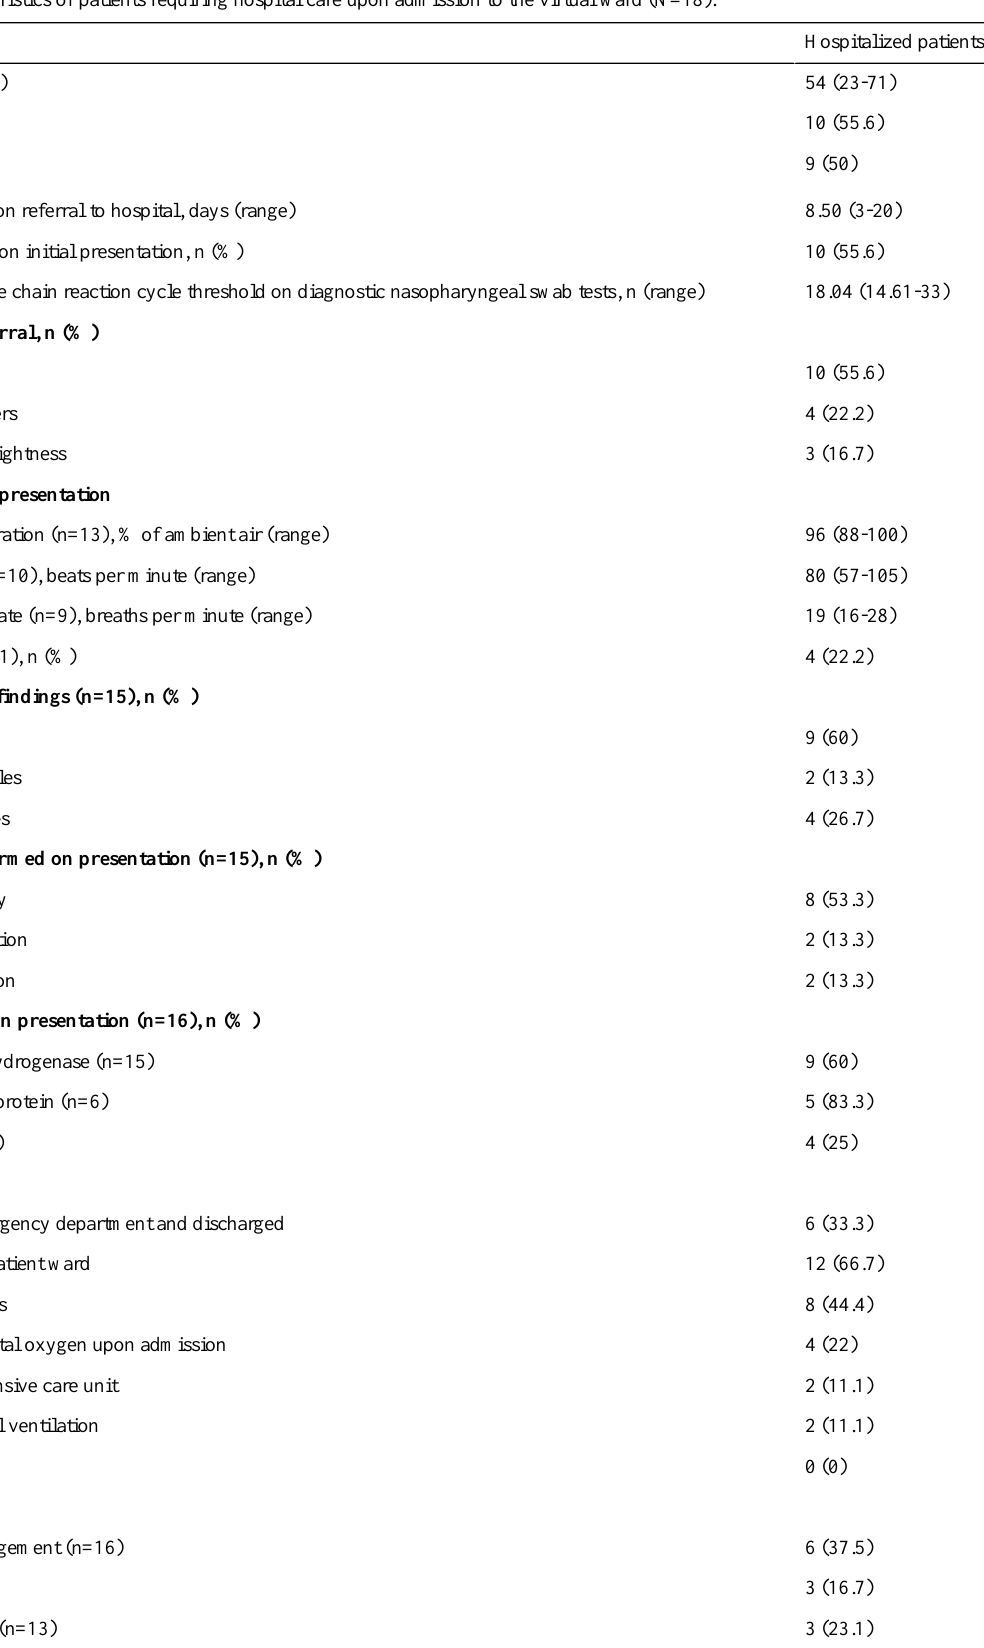
Table 3. Clinical characteristics of patients requiring hospital care upon admission to the virtual ward